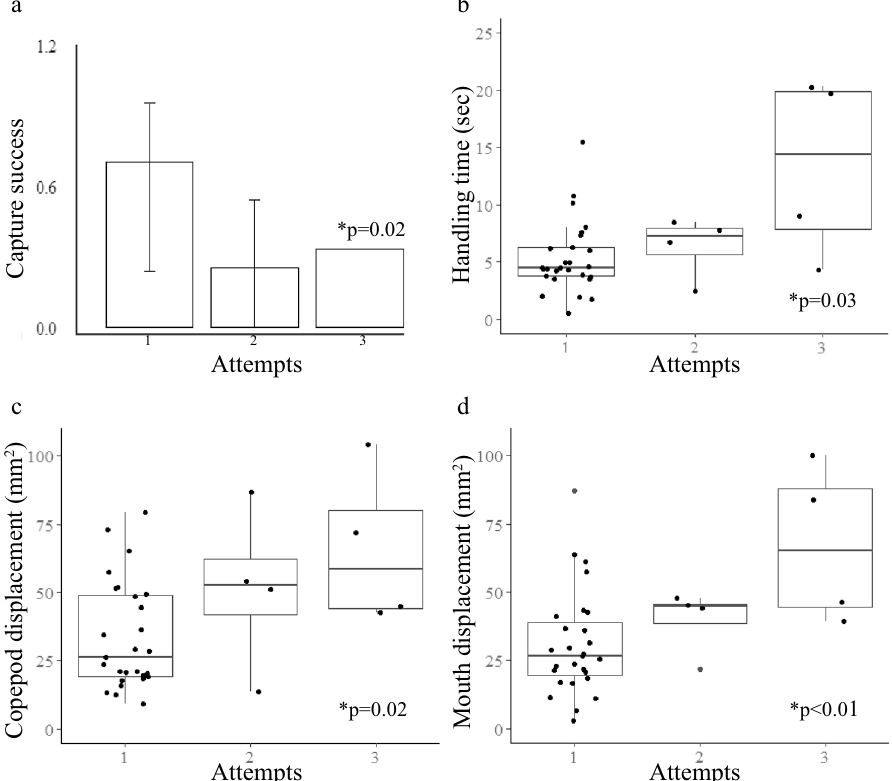
Figure 3. Relationship between number of attempts made in one encounter and ( a ) capture success rate (only one encounter contained three attempts) ( p = 0.02, rho = − 0.38), ( b ) handling time ( p = 0.03, rho = 0.37), ( c ) total copepod displacement ( p = 0.02, rho = 0.38), and ( d ) total mouth displacement ( p < 0.01, rho = 0.46). Thick horizontal lines within each box show median values, vertical lines on either side of each box show standard error, dots represent individual data points.